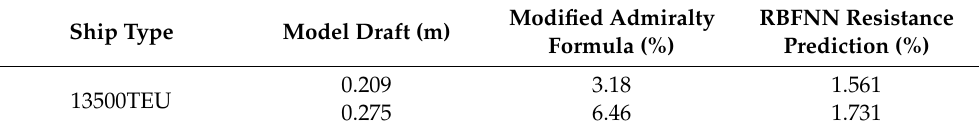
Table 12. The comparison of the MRAE obtained by the two estimate